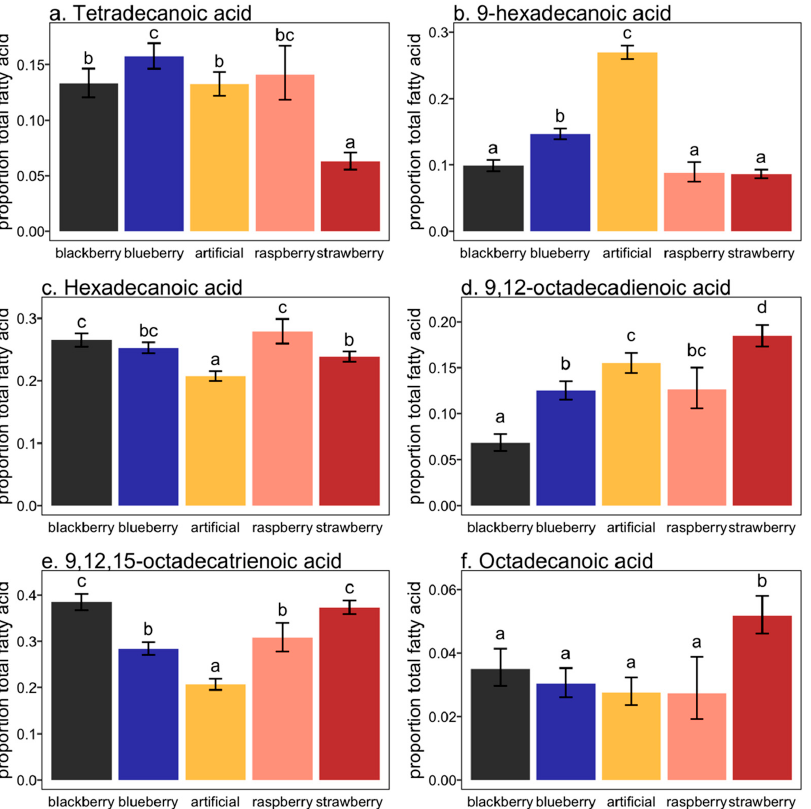
Figure 1. Mean proportion (±SEM) of each fatty acid component for Drosophila suzukii adults reared from different fruit hosts and artificial diet. Different letters indicate significant differences (Tukey from di ff erent fruit hosts and artificial diet. Di ff erent letters indicate significant di ff erences (Tukey HSD; HSD; p < 0.05). p < 0.05). Insects 2020 , 11 , x